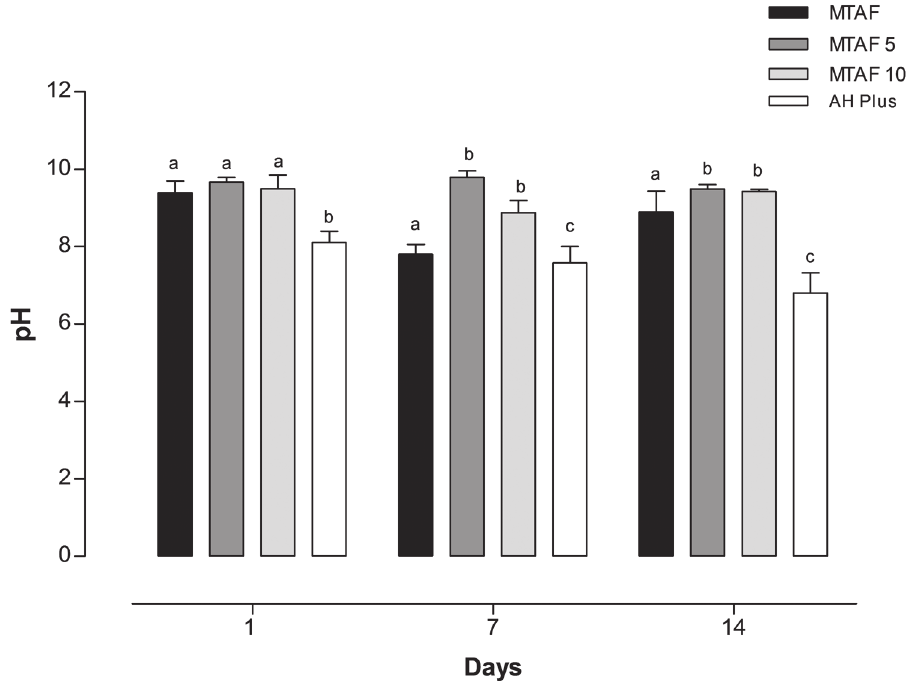
Figure 2- pH from each sealer studied in the different experimental periods. Different letters indicate statistically significant differences (p<0.05)